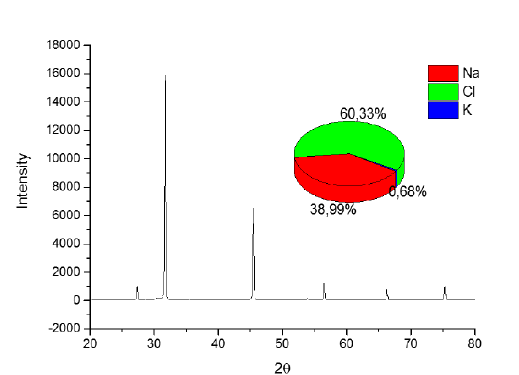
Figure 5. XRD pattern and chemical composition of the crystals obtained in experiment